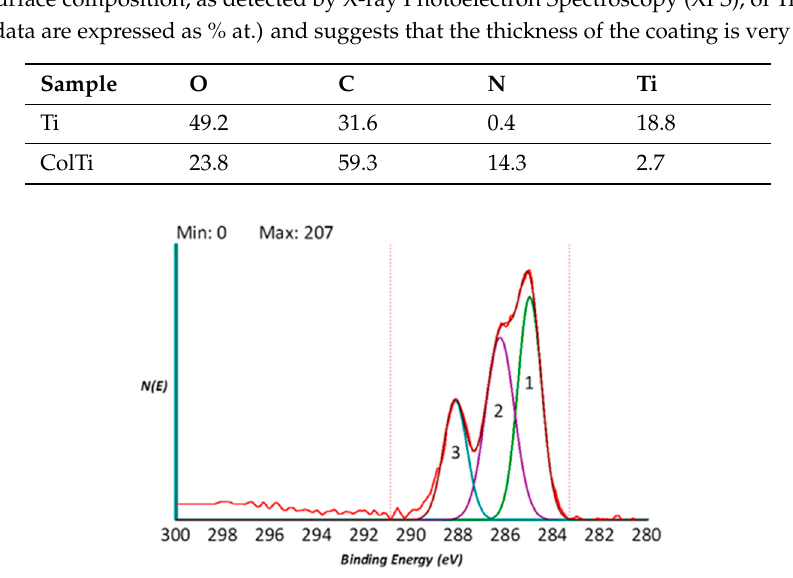
Figure 1. High resolution C1s peak obtained by XPS of ColTi sample. The figure shows the experimental curve (red) and the sum curve (brown) resulting from fitting with 1 (C–C, C–H) (green), 2 (C–N, C–O) (violet) and 3 (C=O, N–C=O functionalities) (azure).